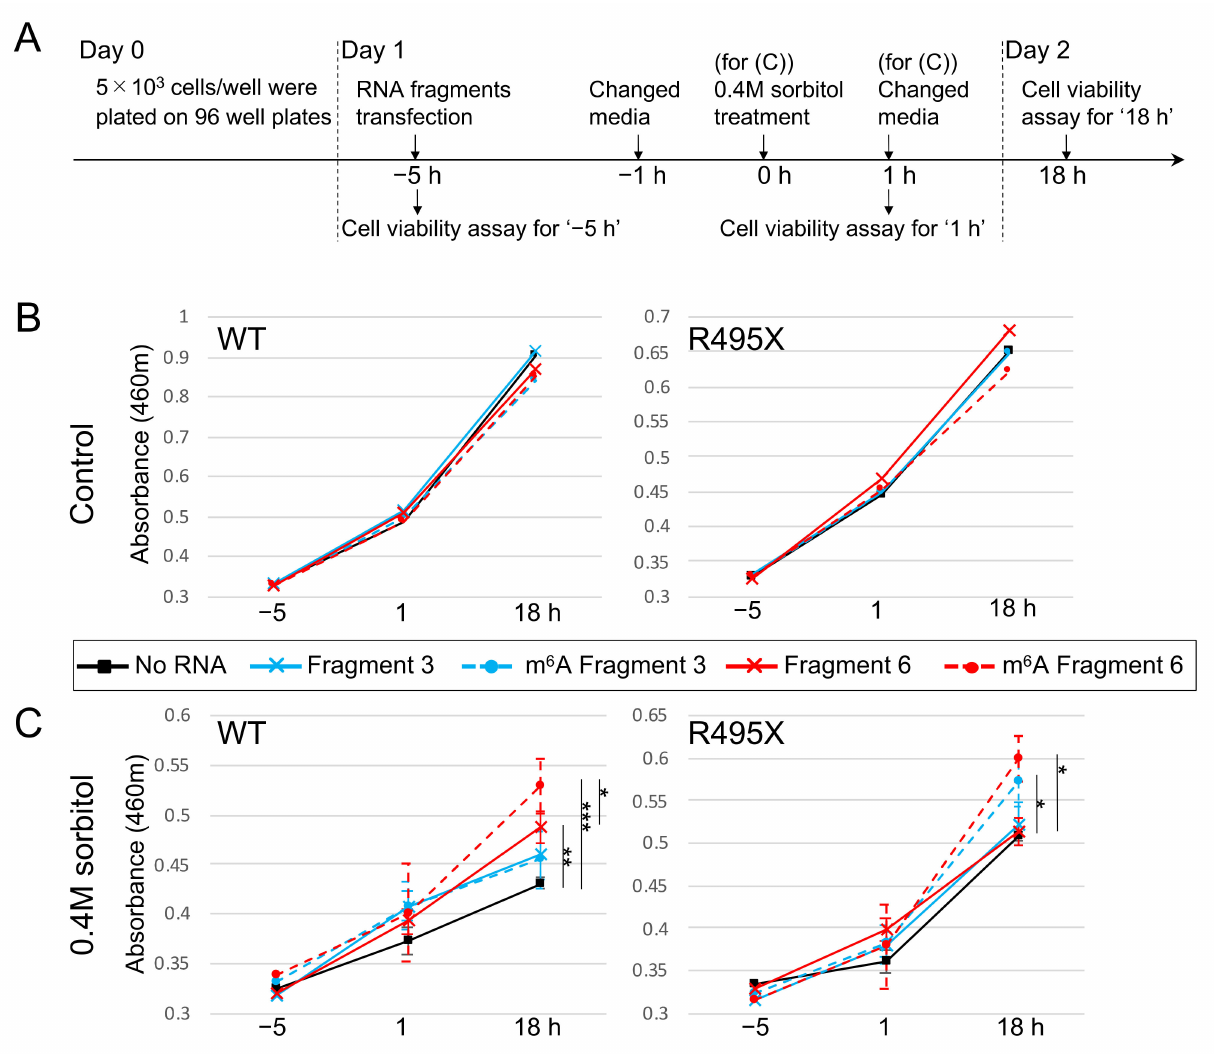
Figure 7. m 6 A-modified RNA fragments enhanced the viability of sorbitol-treated cells. ( A ) Experimental design of ( B , C ). RNA fragments were transfected prior to 0.4M sorbitol treatment, and cell viability was measured at each indicated time point. ( B ) HAP1 cells and the GFP-R495X stable cell line were transfected with indicated RNA fragments, and the cell viability was examined at each time point. ( C ) HAP1 cells and GFP-495X stable cell lines were transfected with indicated RNA fragments prior to 0.4M sorbitol treatment, and the cell viability was examined at each time point. n = 5. * p < 0.05, ** p < 0.01, *** p <